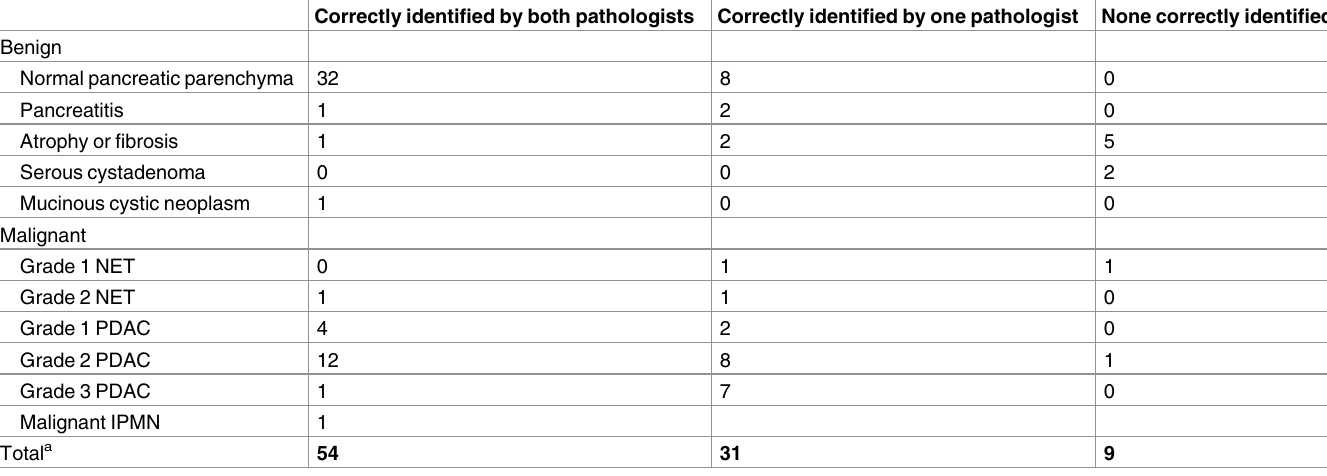
Table 4. Accuracyper histological